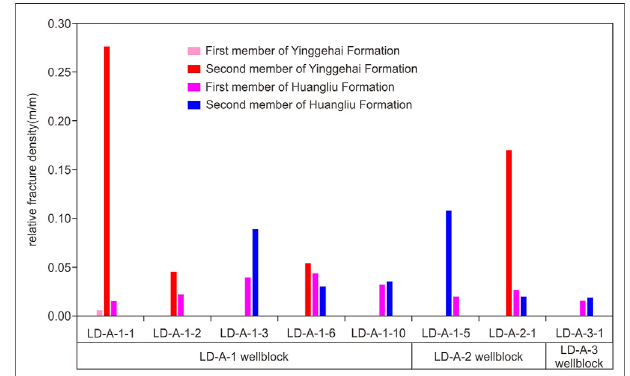
FIGURE 11 | Statistical results of relative fracture density for low- permeability sandstone reservoirs from conventional logging in the LD-A gas fi eld.